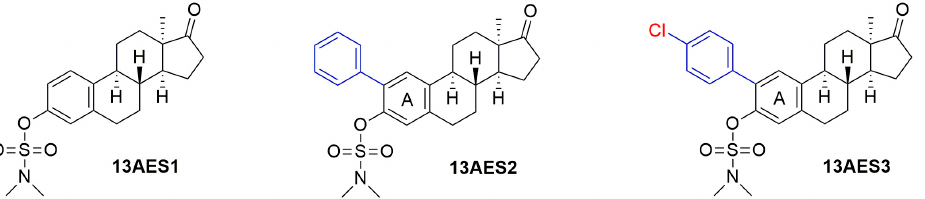
Figure 1. Structure of 3- O -sulfamoyl-13 α -estrone derivatives (13AES1–3) possessing antiproliferative activities.